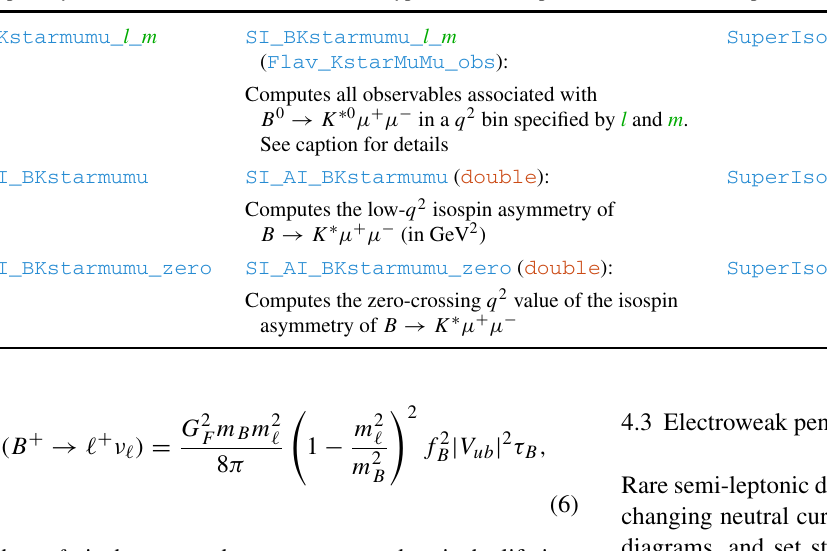
Possible pairs of l and m are (11,25), (25,40), (40,60), (60,80), (15,17) and(17,19);thelasttworefertomomentumtransferrangesof15–17–19 GeV